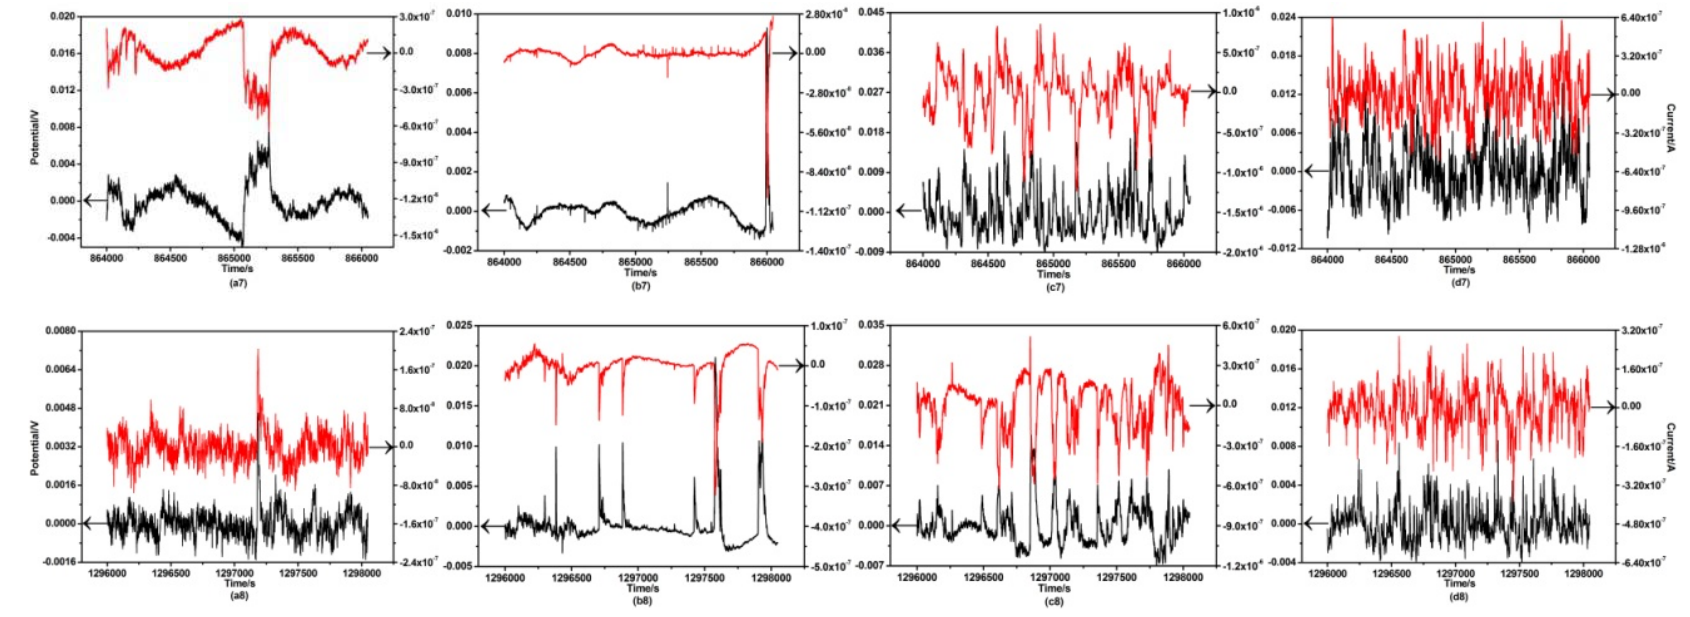
Figure 5. General appearance current and potential time records for ZX30 ( a1 – a8 ), ZK30 ( b1 – b8 ), ZKJ300 ( c1 – c8 ), ZKXQ3000 ( d1 – d8 ) immersed in SBF for 0